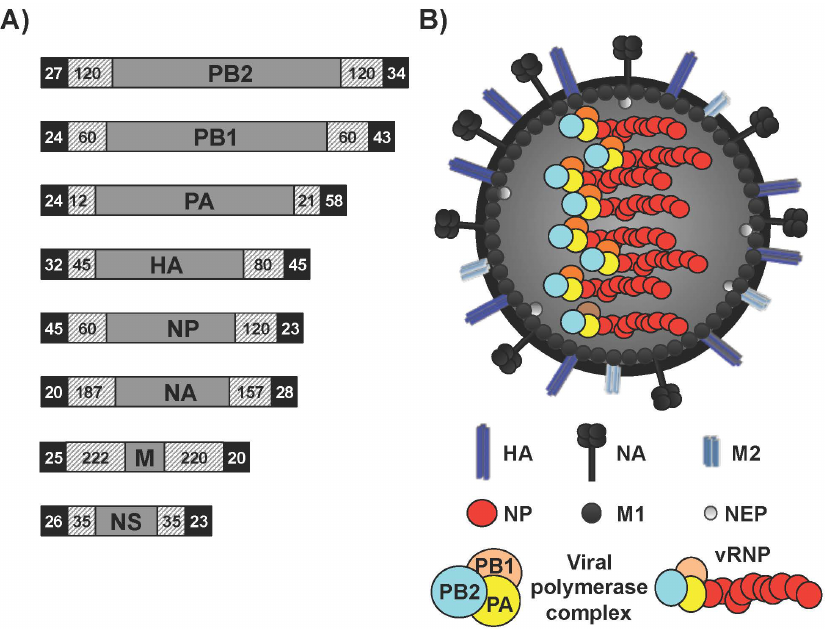
Figure 1. Influenza A virus (IAV) genome organization and virion structure. ( A ) Genome organization: The eight single-stranded, negative-sense, viral (v)RNA segments PB2, PB1, PA, HA, NP, NA, M and NS of IAV are indicated. Black boxes at the end of each of the vRNAs indicate the 3’ and 5’ non-coding regions (NCR). Hatched boxes indicate the packaging signals present at the 3’ and 5’ ends of each of the vRNAs that are responsible for efficient encapsidation into nascent virions. Numbers represent nucleotide lengths for each of the NCR and packaging signals; ( B ) Virion structure: IAV is surrounded by a lipid bilayer containing the two viral glycoproteins hemagglutinin (HA), responsible for binding to sialic acid-containing receptors; and neuraminidase (NA), responsible for viral release from infected cells. Also in the virion membrane is the ion channel matrix 2 (M2) protein. Under the viral lipid bilayer is a protein layer composed of the inner surface envelop matrix 1 (M1) protein, which plays a role in virion assembly and budding; and the nuclear export protein (NEP) involved in the nuclear export of the viral ribonucleoprotein (vRNP) complexes. Underneath is the core of the virus made of the eight vRNA segments that are encapsidated by the viral nucleoprotein (NP). Associated with each vRNP a complex is the viral RNA-dependent RNA polymerase (RdRp) complex made of the three polymerase subunits PB2, PB1 and PA that, together with the viral NP are the minimal components required for viral replication and